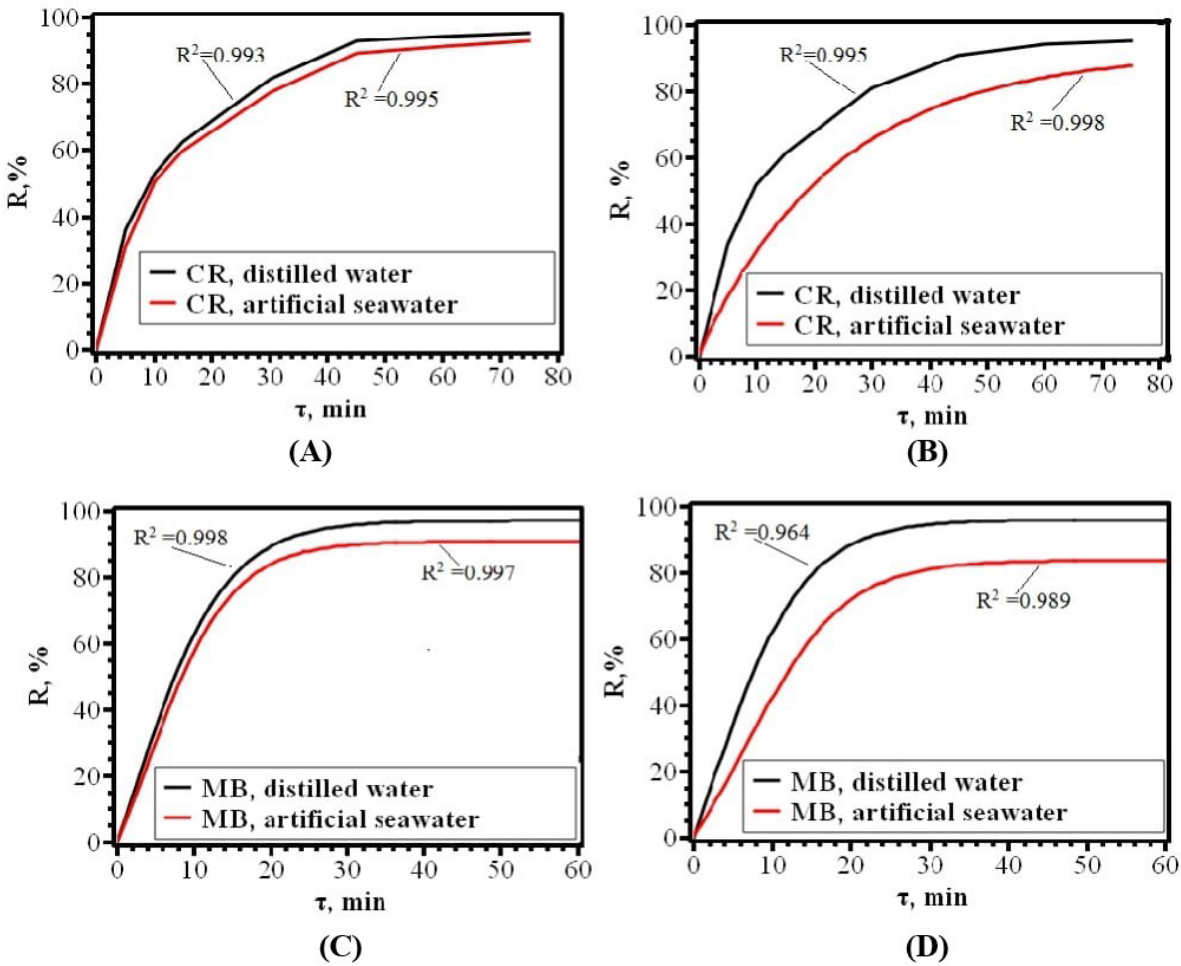
Figure 17. Removal efficiency of CR and MB from distilled water and artificial seawater at 293 K at a concentration of 20 mg L −1 ( A , C ) and 40 mg L −1 ( B , D ).